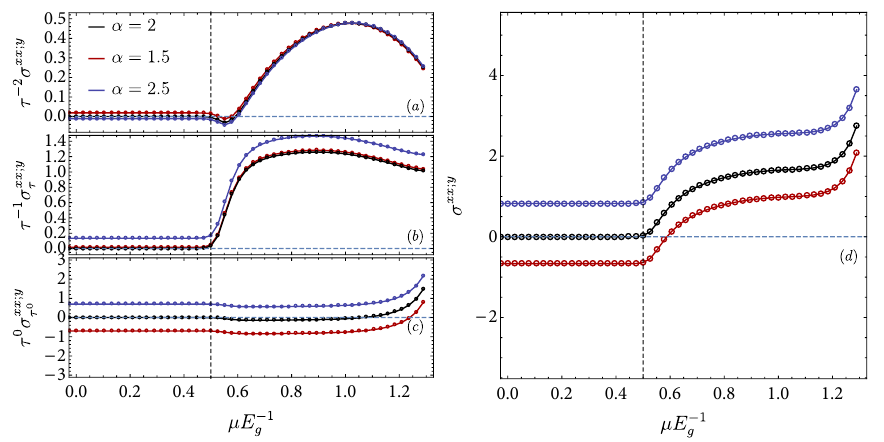
Figure 1: σ xx ; y , σ xx ; y , σ xx ; y , shown in (a), (b), (c), respectively as a function of τ 2 τ 1 2 chemical potential µ , for several values of α = 1.5,2.0,2.5. In (d), we plot the total conductivity, with τ = 1. The interval in µ to the left of the vertical dashed lines denotes the gapped region of the model in App. C. Note that for α = 2, the in-gap signal vanishes identically, as all the remaining terms are now require a Fermi surface. The proper reflection of this Figure for µ < 0, due to particle-hole symmetry, is explained in App. G. The lines are guides to the eye, and the azure horizontal dashed lines denotes the zero ordinate for each conductivity σ xx ; y τ . For ease of presentation n we set e = ħ h =